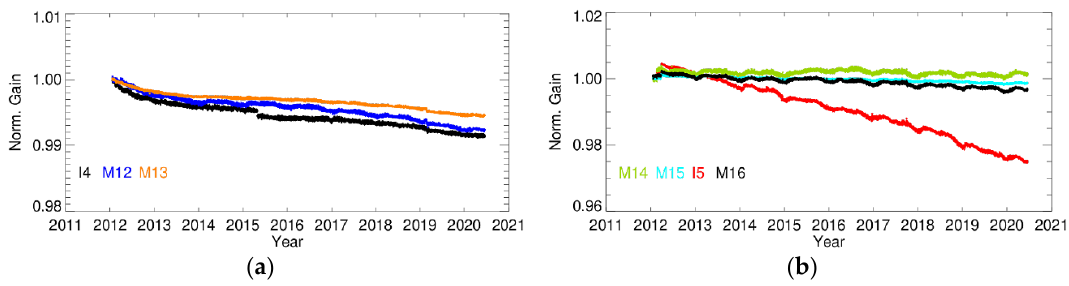
Figure 14. Normalized detector gains of S-NPP VIIRS short- and mid-wave infrared (SMIR) bands ( a ) and long-wave infrared (LWIR) bands ( b ) derived from on-board BB (band averaged, HAM side 1).